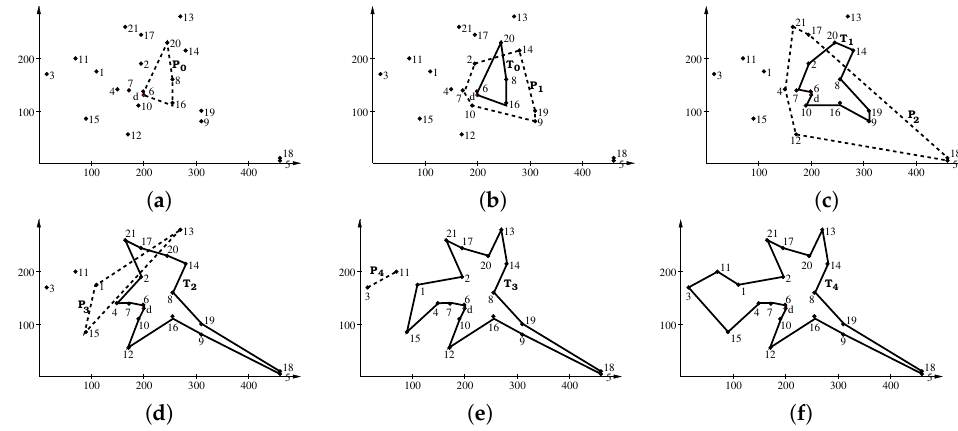
Figure 25. Iterations performed to resolve the instance of Iguala by the inflammation method.